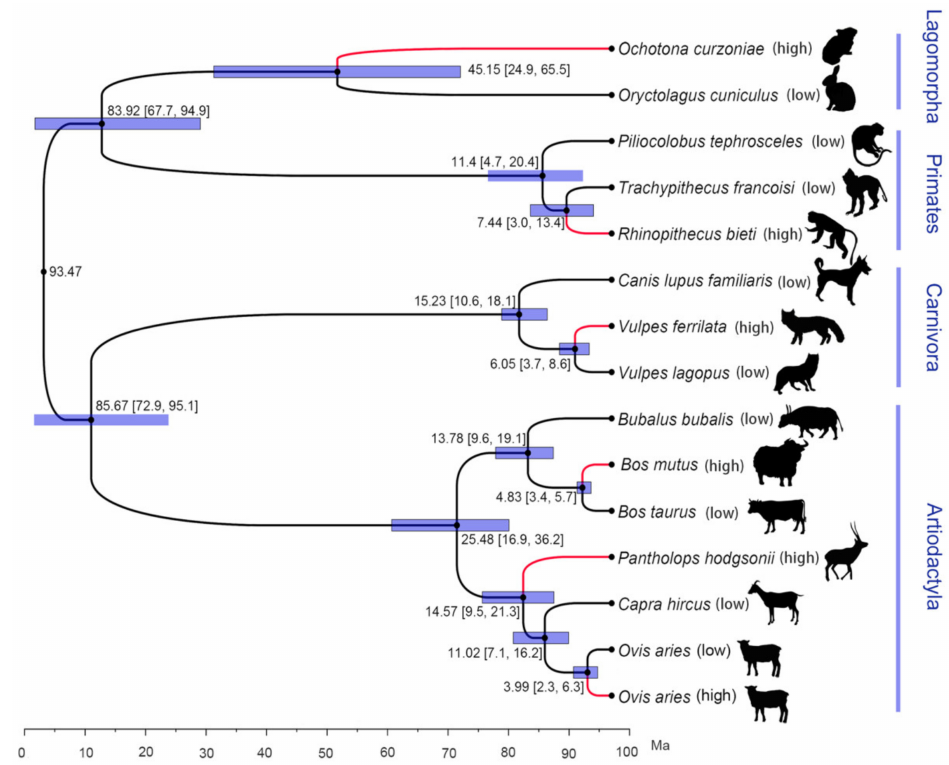
Figure 1. Phylogenetic relationship and divergence time estimation of six high-altitude species and their relatives based on one-to-one homologous genes. The red branches represent species from high